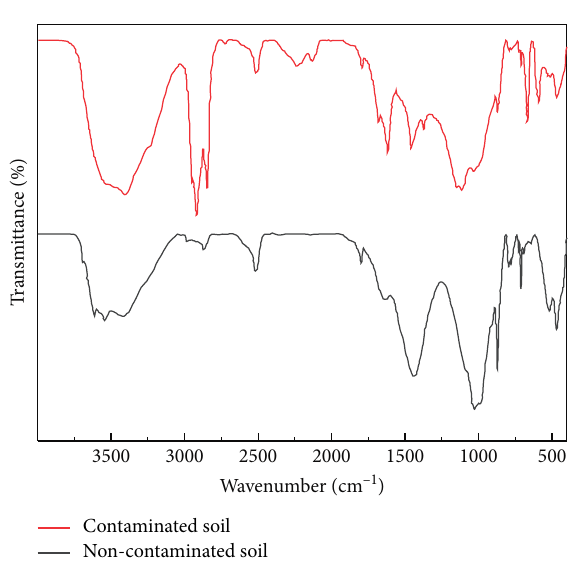
Figure 2: FTIR scans of oil-contaminated (red line) and non- contaminated soil (black